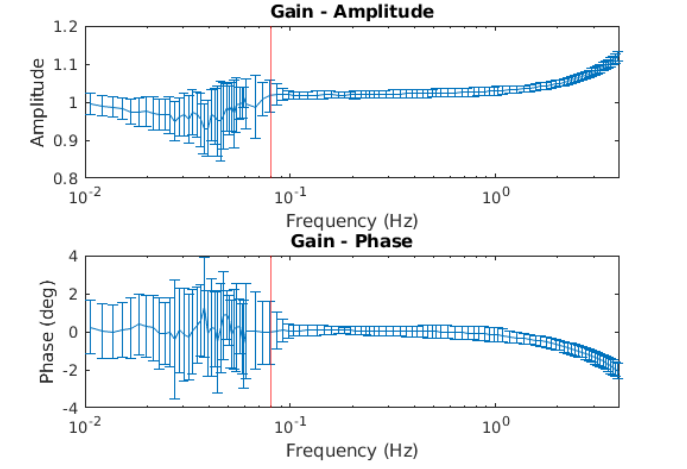
Figure 6. Calibrated gain of an 18 m WNRS. Top panel is the amplitude of the gain and the bottom panel is the phase of the gain in degrees. For each frequency, the mean and standard deviations (vertical interval) are represented. The red bars highlight the point at approximately 0.08 Hz, which denotes the frequency at which the dip artifact ceases.